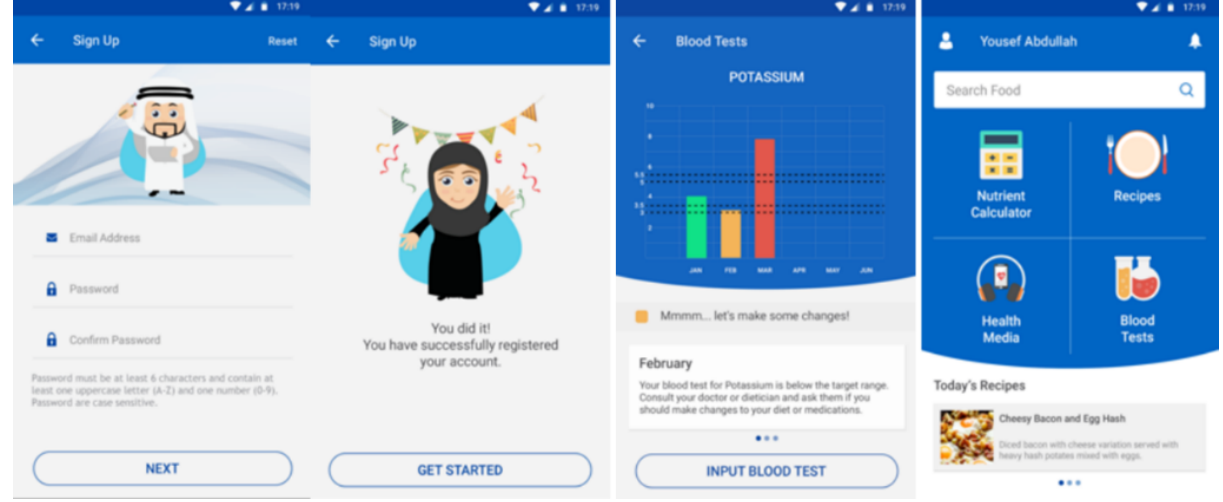
Figure 1. Screenshots of the KELA.AE app used during the pilot